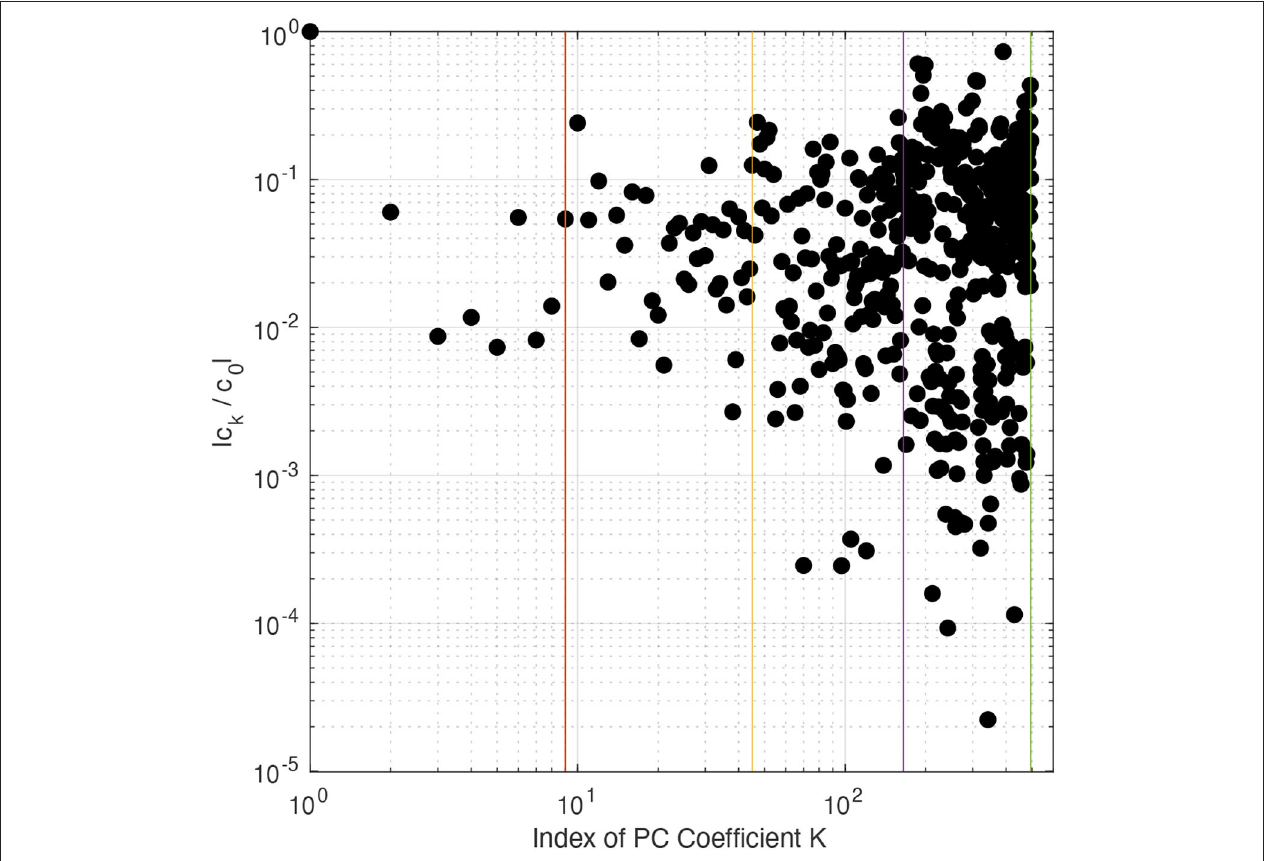
FIGURE 1 | PCE normalized coefficients c k /c 0 for PC of order up to r = 4. Vertical lines separate the PCE terms into their different PC orders. PCE coefficients were calculated using the non-intrusive spectral projection (NISP)